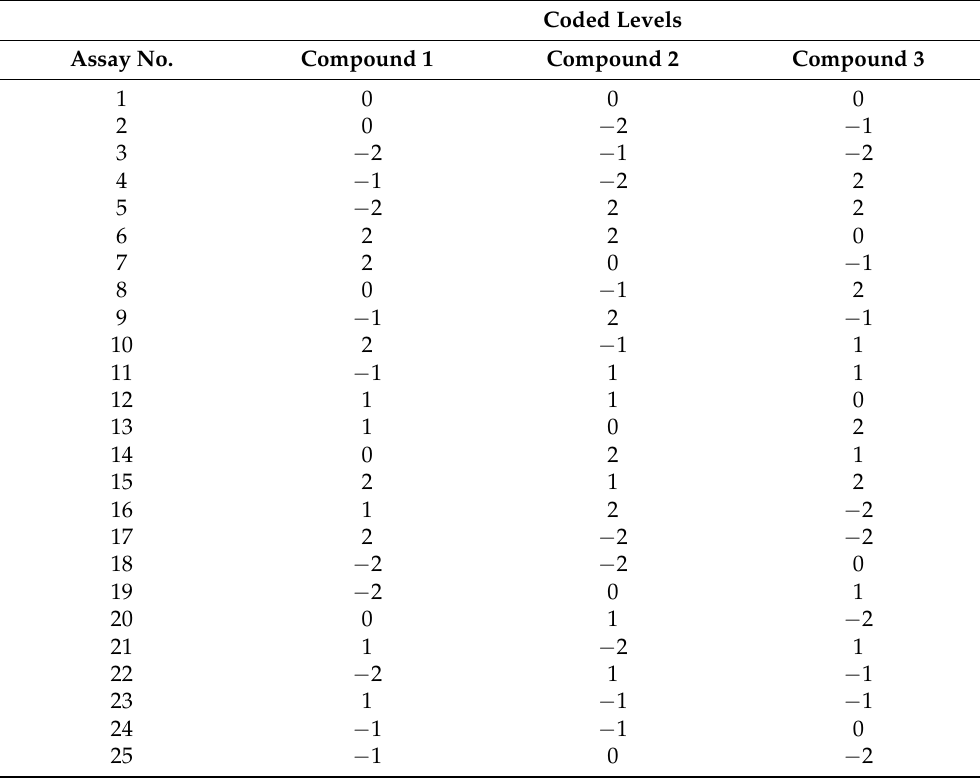
Table 1. A fractional factorial design for the mixing of 3 compounds with 5 different concentrations to assure orthogonal concentrations. Coded Levels Assay No. Compound 1 Compound 2 Compound 3 1 0